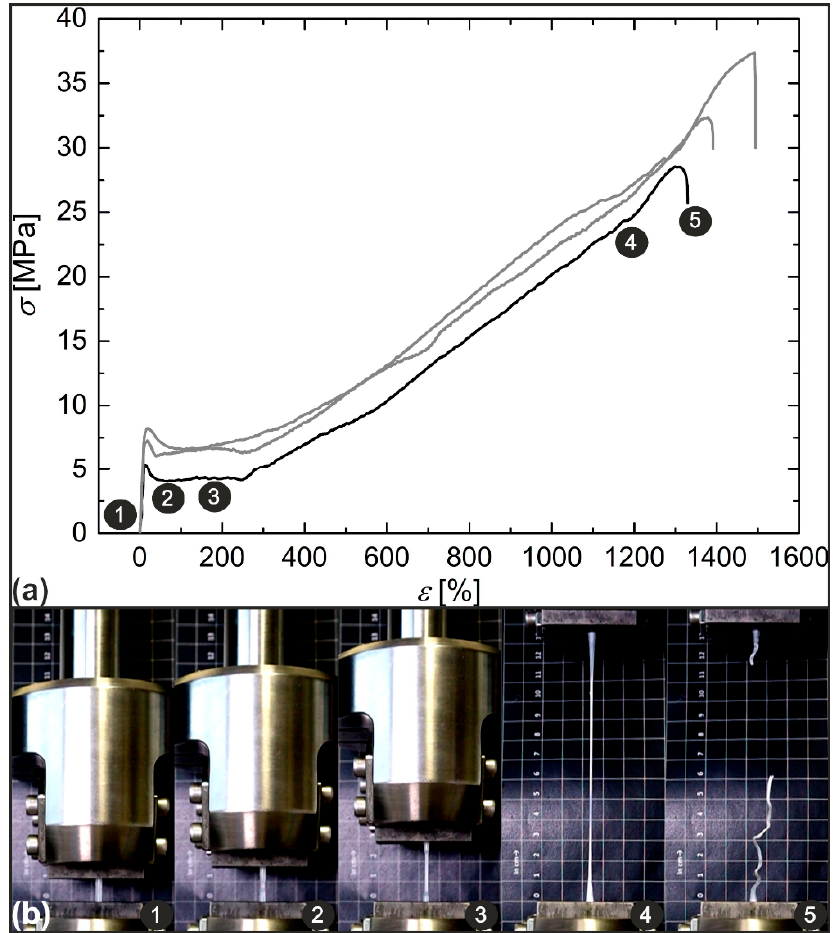
Figure 4. Mechanical characterization of PDA-based PEU using tensile tests: engineering stress– strain curves ( a ) and the associated deformation behavior ( b ). The experiments were carried out on tensile bars at 23 °C with an initial strain rate of 1%·min –1 until 5% of strain were reached and continued with 2000%·min –1 until rupture occurred.